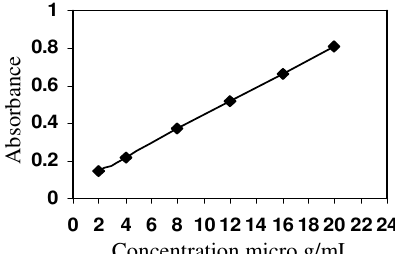
Figure 3 . Standard plot of tadalafil.